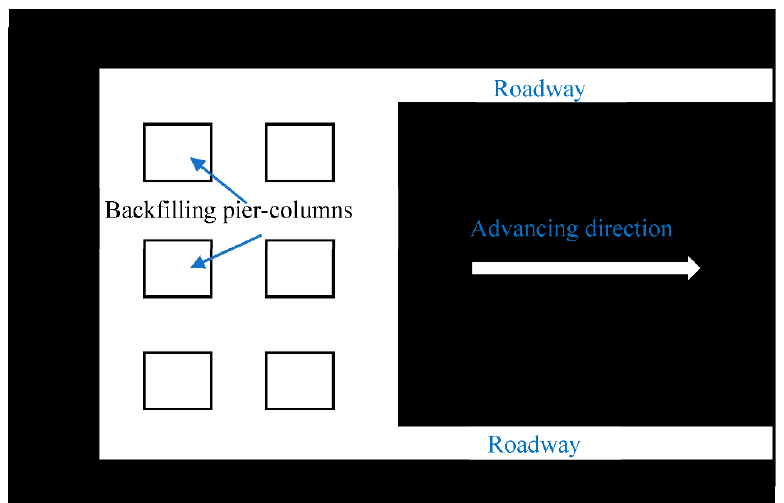
Figure 1. Schematic diagram of longwall pier ‐ column backfilling.